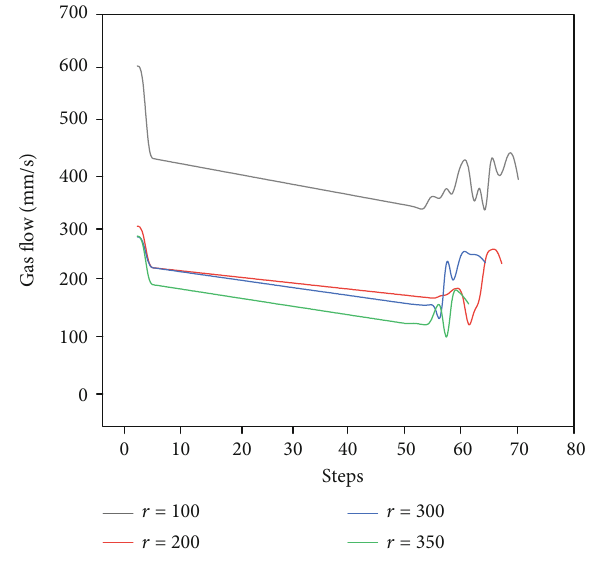
Figure 16: Flow patterns of 4 holes.